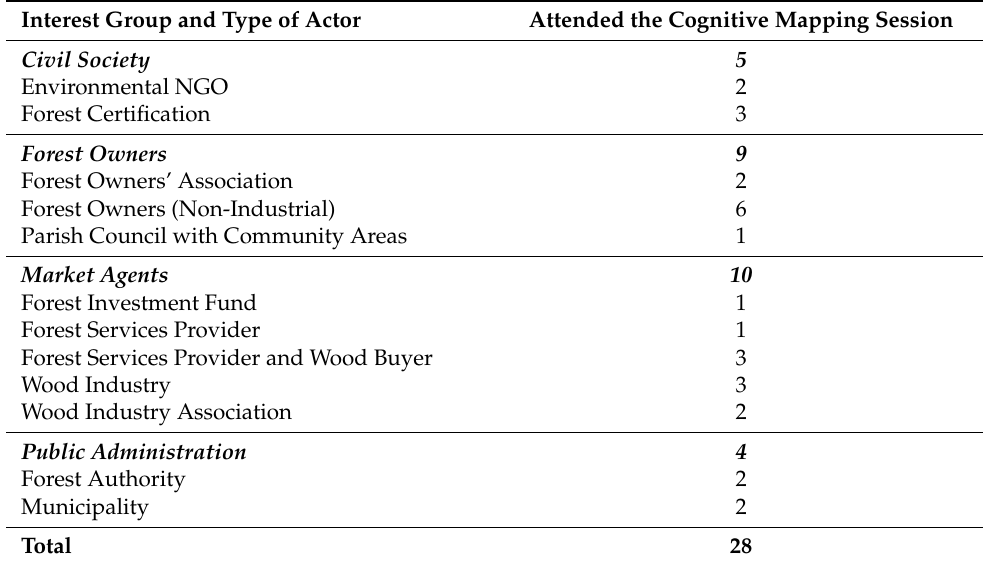
Table 1. Identification of the actors who attended the cognitive mapping session by interest